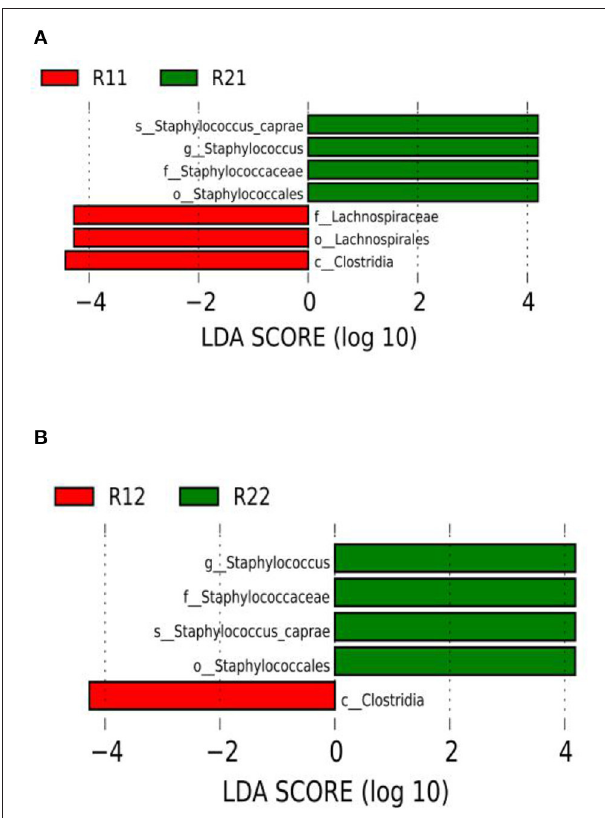
FIGURE 4 | LEfSe comparison between the study and control groups. (A) LDA score histogram of differential microbiota of the two groups on day 1 of life. (B) LDA score histogram of differential microbiota of the two groups on day 3 of life; c _ represents class level, o_ represents order level, f_ represents family level, g_ represents genus level, and s_ represents species level. The length of the column represents the LDA value, and the greater the value, the greater the influence of the dominant flora. LDA, linear discriminant analysis; LEfSe, linear discriminant analysis effect size; R11, gut flora of the study group on day 1; R21, gut flora of the control group on day 1; R12, gut flora of the study group on day 3; R22, gut flora of the control group on day 3.